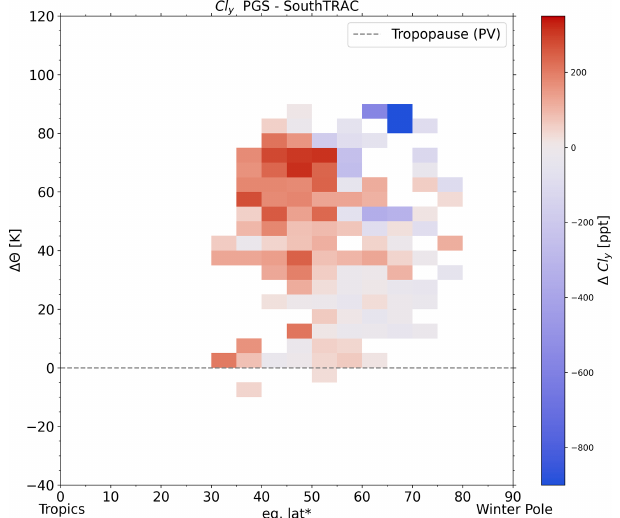
Figure 10. Difference of the latitude–altitude cross section of Cl y from PGS and SouthTRAC. Data are binned using equivalent latitude ∗ and (cid:49)(cid:50)